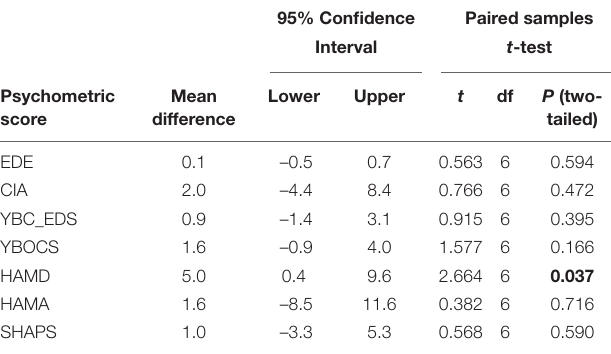
TABLE 7 | Difference in psychometric scores during double-blind period (DBS OFF – DBS ON). 95% Confidence Paired